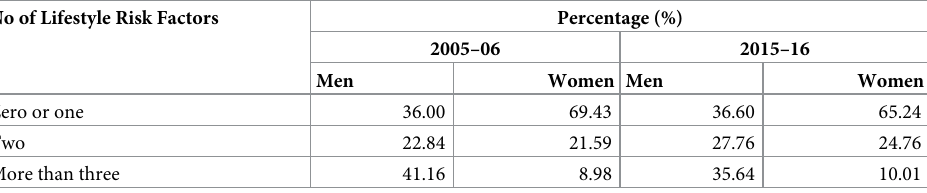
Table 2. Co-occurrence of lifestyle risk factors among adults in